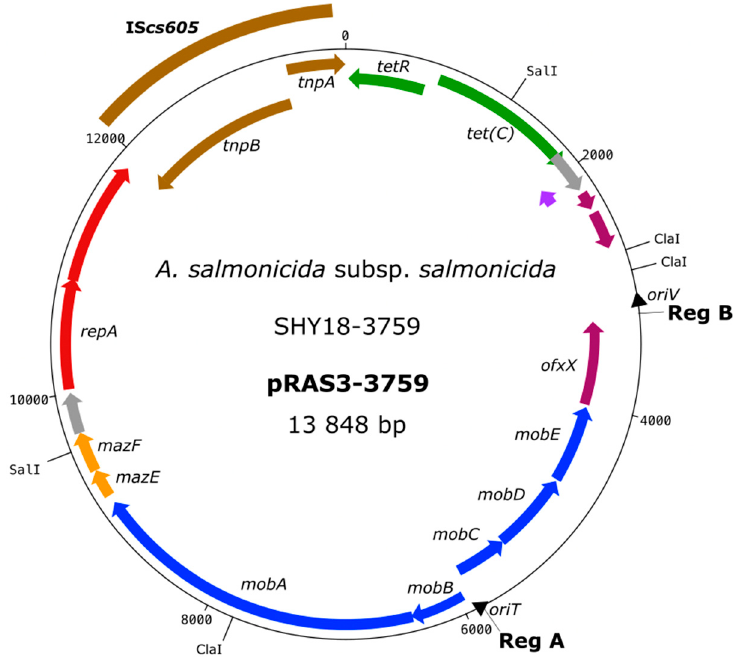
Figure 3. Plasmid map of pRAS3-3759. Genes are represented by arrows. Genes more on the outside are transcribed clockwise, while genes on the inside are transcribed counterclockwise. Green arrows represent genes coding for antibiotic resistance, while the brown arrows represent the genes coding for the transposition of the IS sc605 . Orange arrows code for an active toxin/antitoxin pemk-like system. Recognition sites of the restriction enzymes used for enzymatic digestion ( SalI and ClaI ) are shown outside the ring.